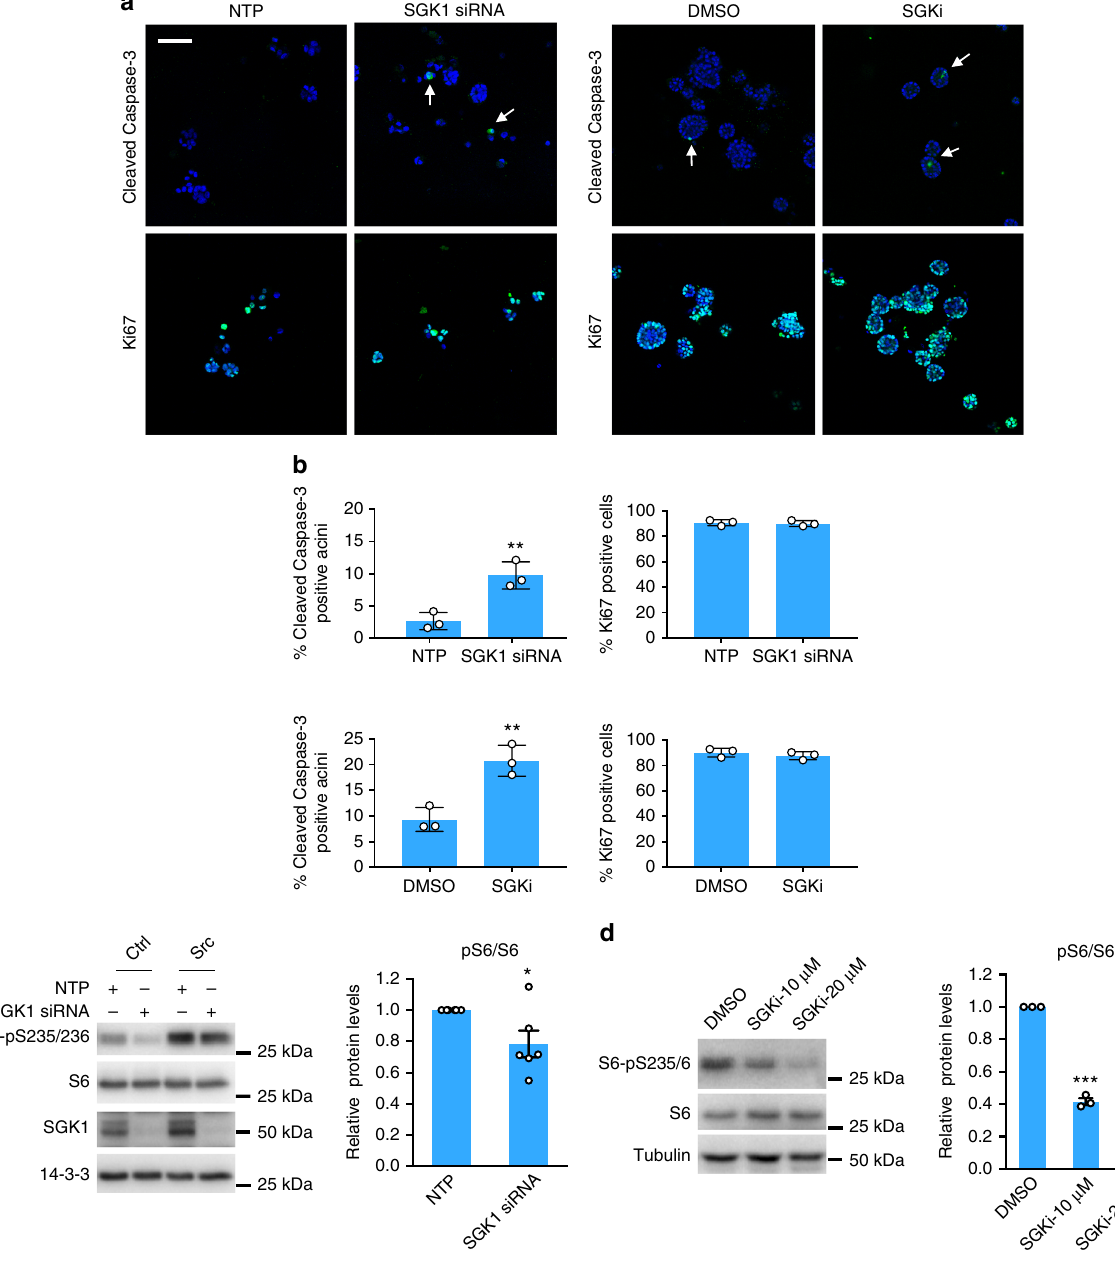
Fig. 6 Functional characterization of SGK1 in MCF-10A_Src cells. a SGK1 knockdown or inhibition increases apoptosis in MCF-10A_Src acini. MCF-10A_Src cells were transfected with a SGK1 siRNA SMARTpool or non-targeting control (NTP) (40 nM) (left) or treated with a selective SGK1 inhibitor (SGKi) (10 μ M) (right), and grown in 3D culture for 3 days or 5 days, respectively. Immuno fl uorescent imaging was performed using Ki67 and cleaved Caspase-3 antibodies (green) and DAPI counterstain (blue). Representative images are shown. Arrows indicate cleaved Caspase-3 positive acini. Scale bar represents 100 μ m. b Percentage of cleaved Caspase-3 or Ki67 positive acini from n = 3 biological replicates. At least 50 acini were analyzed in each replicate. ** p < 0.01 by Student ’ s t -test. c Knockdown of SGK1 decreases mTOR activity in 2D culture. MCF-10A_Ctrl and MCF-10A_Src cells were transfected with a SGK1 siRNA SMARTpool or non-targeting control (NTP) (40 nM) and cultured in – EGF medium for 24 h before harvesting. Cell lysates were western blotted as indicated. Representative blots are shown from n = 6 biological replicates. The column graph shows quanti fi cation of p-S6 normalized to S6, error bars represent s.e.m., * p < 0.05 by Student ’ s t -test. d SGK1 inhibition decreases mTOR activity in 3D culture. MCF-10A_Src cells in 3D culture were treated with SGKi for 24 h and harvested for western blot analysis. Representative blots are shown from n = 3 biological replicates. The column graph shows quanti fi cation of p-S6 normalized to S6, error bars represent s.e.m., *** p < 0.001 by Student ’ s t